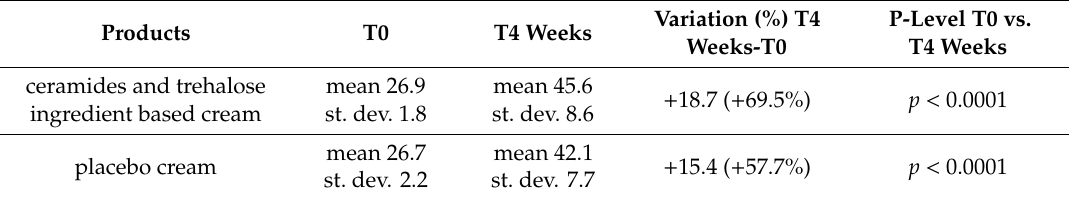
Table 2. Mean values, standard deviations, variations, and statistical significance ( t -test) of skin hydration on 20 analyzed subjects.